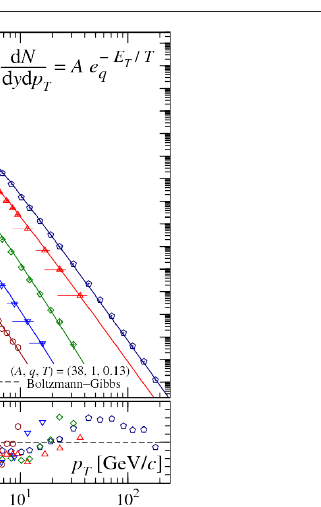
Figure 1. Comparison of Eq. (1) with the experimental transverse momentum distribution of hadrons in pp collisions at central rapidity y . The corresponding Boltzmann-Gibbs distribution is shown as a dashed curve. The data / fit ratios are shown at the bottom where a log-periodic behaviour is observed on top of the q -exponential one